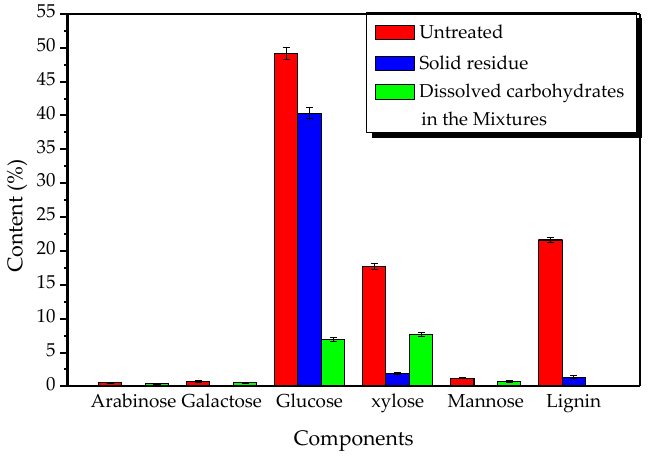
Figure 4. The composition of solid residue and dissolved carbohydrates in the mixtures after choline chloride-lactic acid (ChCl-Lac, molar ratio 1:10) treatment at 120 °C for 12 h (on dry basis of the initial sample). Table 1. The chemical composition of the solid residue and dissolved in the mixtures after choline chloride-lactic acid (ChCl-Lac) (1:10) treatment at 120 °C for 12 h (as a percentage of the initial component).